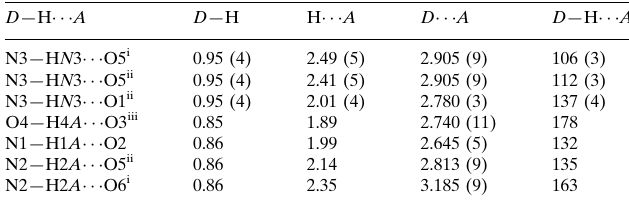
Data collection Bruker SMART CCD area-detector diffractometer Absorption correction: multi-scan ( SADABS ; Bruker, 1997) T min = 0.980, T max = 0.984